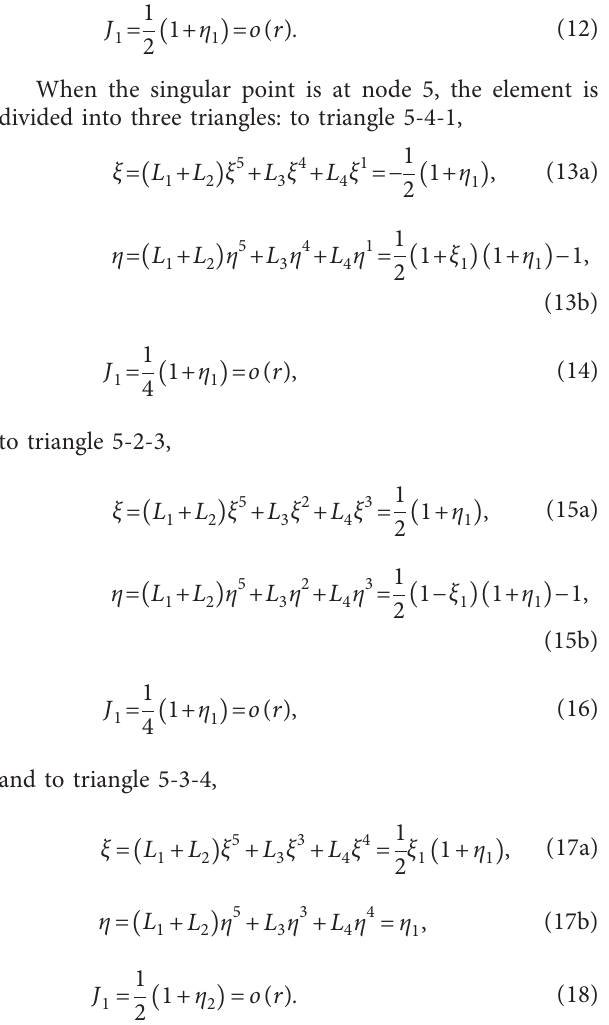
Figure 3: Singularity at node 1or node